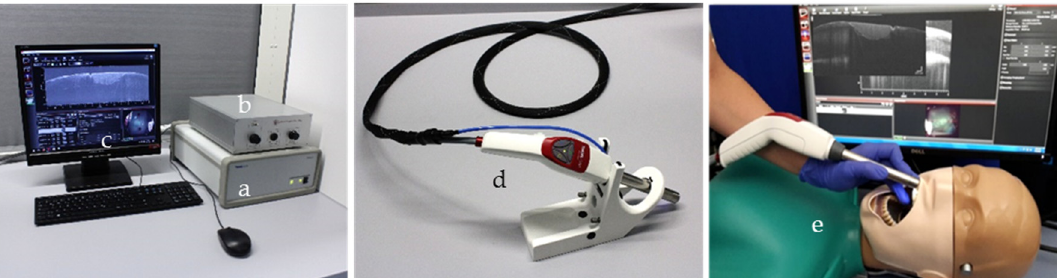
Figure 1. Images of the complete set-up including the OCT system ( a ), custom-designed reference arm ( b ), peripheral equipment of the PC ( c ), and the modified hand-held scanner ( d ). To evaluate and optimize the handling of the hand-held scanner, a patient equivalent simulation ( e ) was used to perform test measurements on artificial sets of teeth and, in addition, also on extracted human teeth.